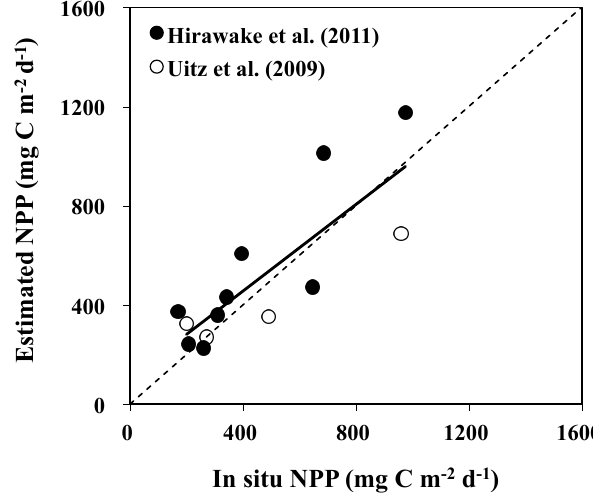
Fig. A1. A comparison between in situ NPP and satellite NPP es- timated by the method of Hirawake et al. (2011). Solid and dashed lines indicate the regression line and 1:1 line, respectively.